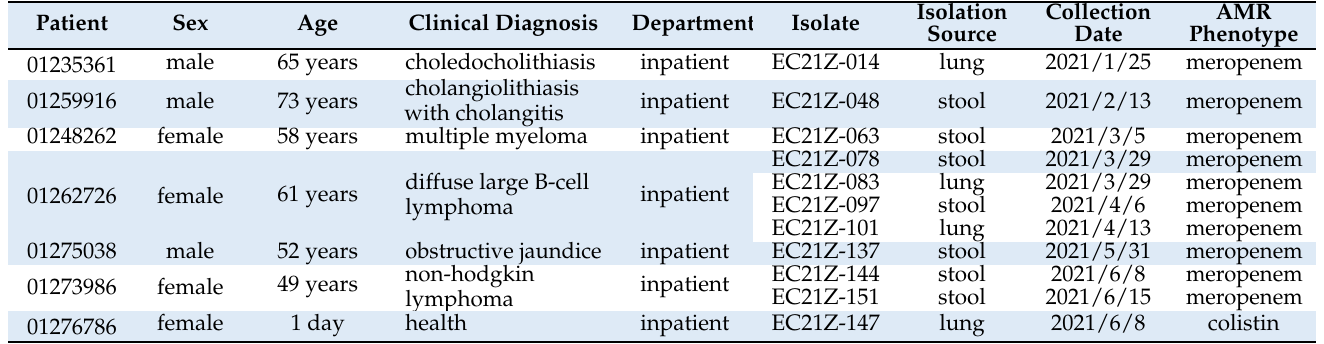
Table 1. Source information of 11 E. coli isolates with meropenem- or colistin-resistant